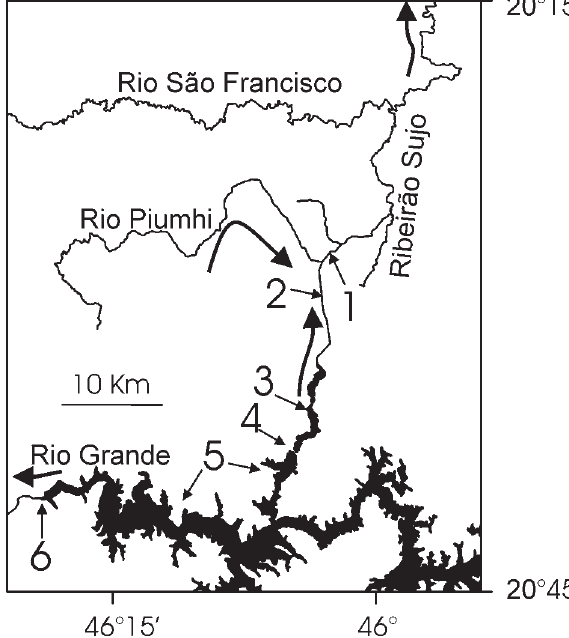
Fig. 3. Piumhi watershed transposition: (1) transposition ca- nal, (2) canal for reversed flow from remnants of lower Piumhi drainage, (3) artificial lake formed at lower Piumhi drainage after construction of Capitólio dam, (4) Capitólio dam, (5) Furnas lake, formed by the Furnas Hydroelectric Dam, (6) Furnas Dam on the rio Grande.